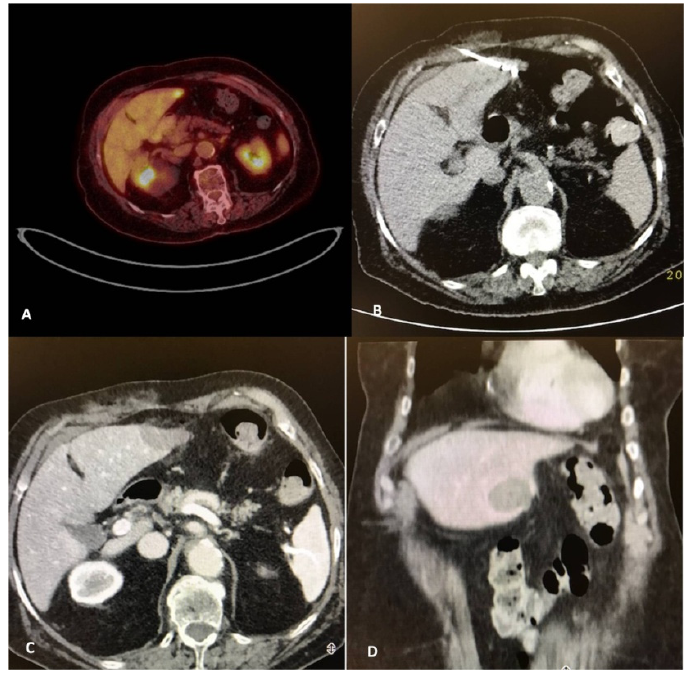
Figure 2. A 82-year-old, female patient with a medical record of colorectal cancer (operated) and a solitary PET avid liver metastasis depicted 9 months post-initial diagnosis ( A ). Due to comorbidities and in agreement with the patient’s desire, the tumor board decision was percutaneous microwave ablation, which was performed under computed tomography guidance ( B ). Contrast-enhanced computed tomography scan (portal venous phase) illustrates the zone of necrosis immediately post-ablation in axial ( C ) and coronal reconstructions ( D ).